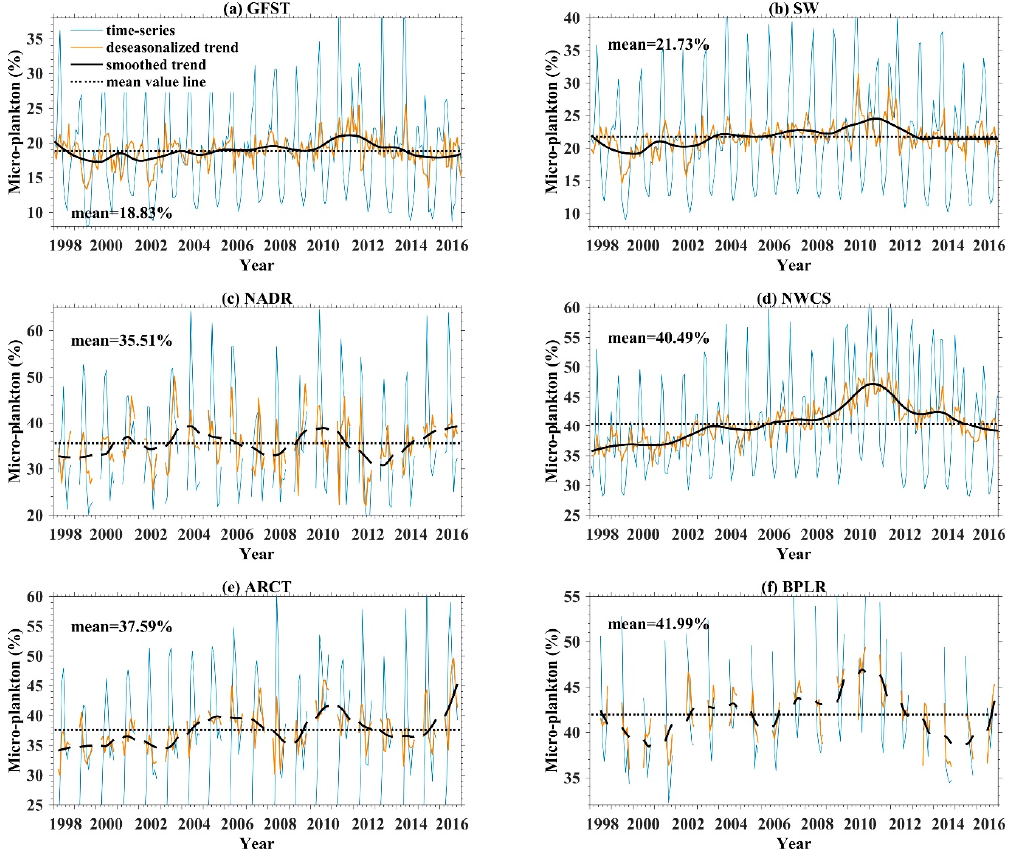
Figure 9. Time-series of microphytoplankton in ecological provinces of ( a ) Gulf Stream, ( b ) Slope Waters, ( c ) North Atlantic Drift, ( d ) Northwest Continental Shelf, ( e ) Arctic Waters, and ( f ) Polar Boreal Current. The deseasonalized trend and smoothed trend are also shown for each province.